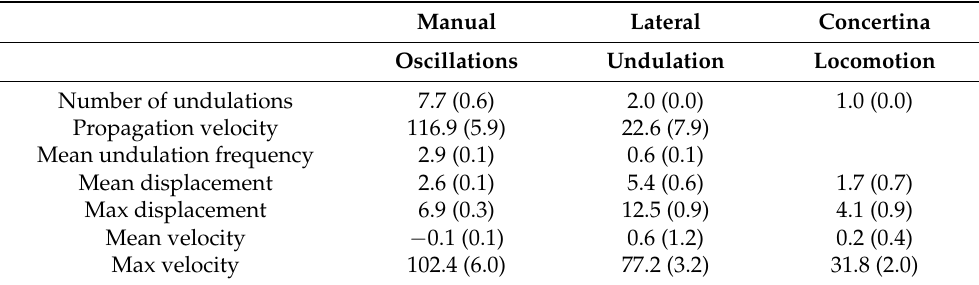
Table 1. Summary of the kinematic features during the manual oscillations, lateral undulations, and concertina locomotion; values are presented as mean (s.e.). During concertina locomotion there is no propagation of the body segment. Displacements are all given in cm, velocities in cm/s, and frequency in Hz. Note that for velocity calculations, movement away from the long axis of the snake was treated as positive, and movement toward the snake was treated as negative. The manual oscillation data represent three trials on each of the 7 snakes. A total of 5 lateral undulation and 5 concertina locomotion bouts were quantified; these were recorded from 6 of the Candoia aspera , with four specimens contributing one of each type of locomotion. Manual Lateral Concertina Oscillations Undulation Locomotion Number of undulations 7.7 (0.6) 2.0 (0.0) 1.0 (0.0) Propagation velocity 116.9 (5.9) 22.6 (7.9) Mean undulation frequency 2.9